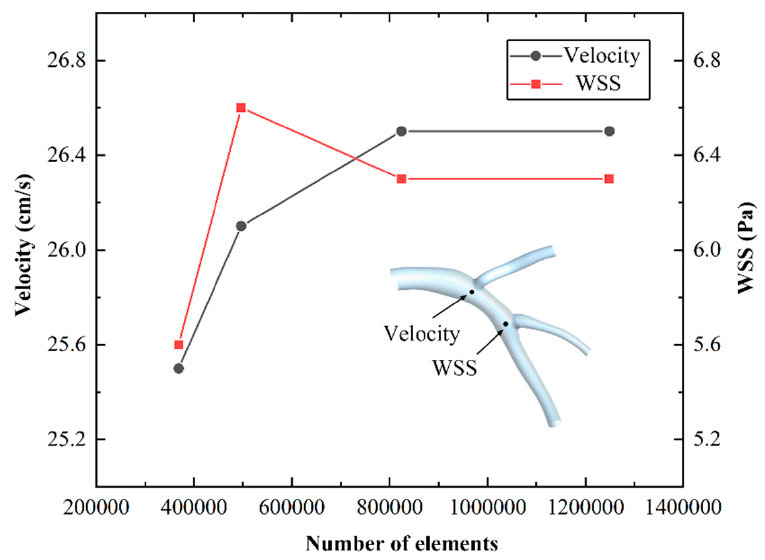
Figure 3. Variation in the velocity and WSS with the number of mesh elements.